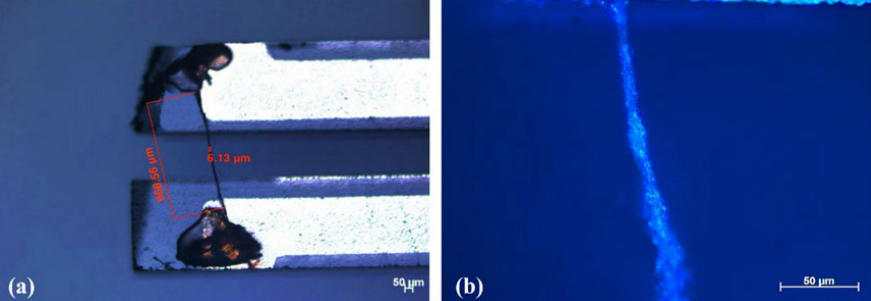
Figure 1. Photographs of an SSM-QTF taken with a Zeiss optical microscope. ( b ) is the enlarged view of ( a ).